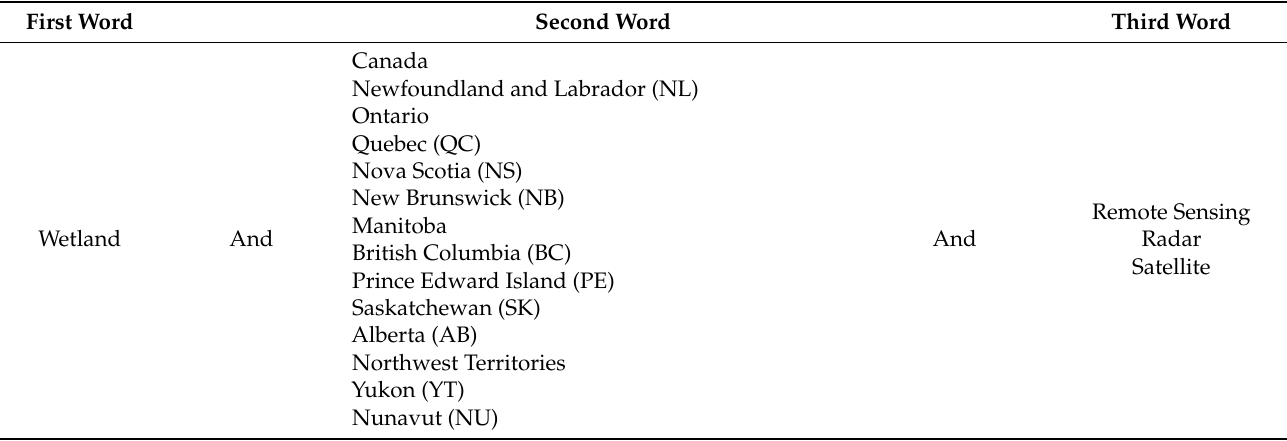
Figure 2. Workflow of preparing content analyses of this review paper. Table 1. List of search words to prepare the procurements of this